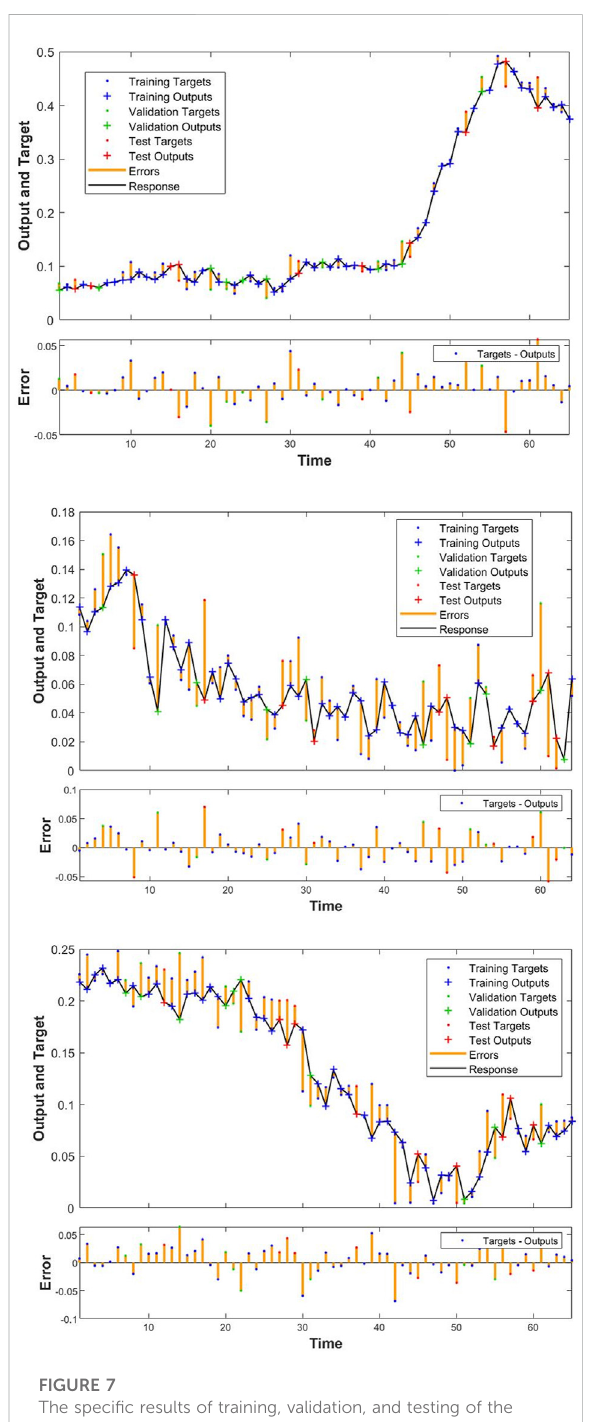
FA-NAR model. (A) Results of training, veri fi cation, and testing at thepressurelevel. (B)Results oftraining, veri fi cation,and testingat the state level. (C) Results of training, veri fi cation, and testing at the response level.